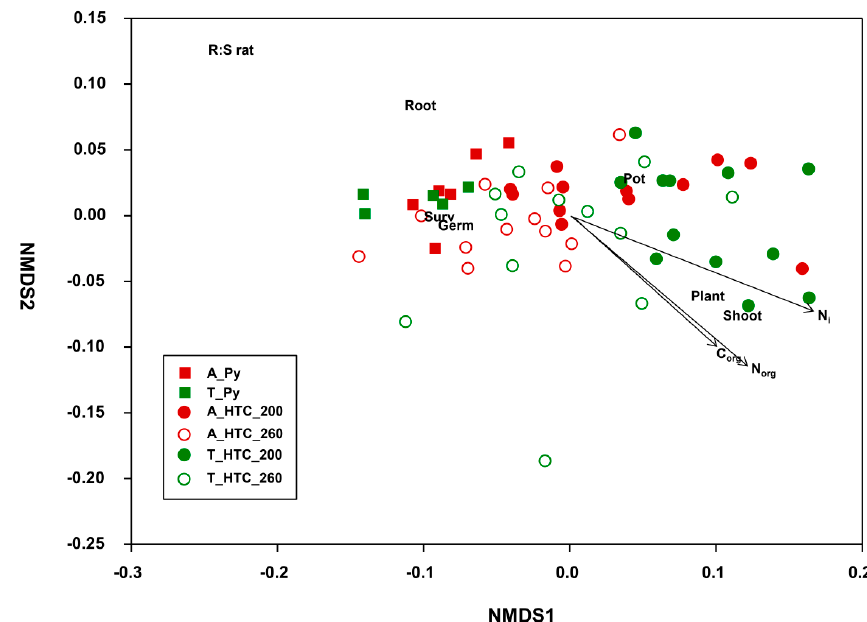
Figure 5. Non-metric multidimensional scaling (NMDS) ordination indicates how the different thermally treated sewage sludges (SS) impact on Lolium -measured parameters. R:S rat: root-to shoot ratio; Roots: roots biomass per plant; Surv: survival rate; Germ: germination rate; Pot: total biomass per pot; Plant: total biomass per plant; Shoot: shoot biomass per plant. Char properties significantly fitting onto the NMDS are shown as vectors ( p < 0.01). N i : inorganic nitrogen; N org : organic nitrogen; Corg: organic carbon. Goodness of fit was 0.05.